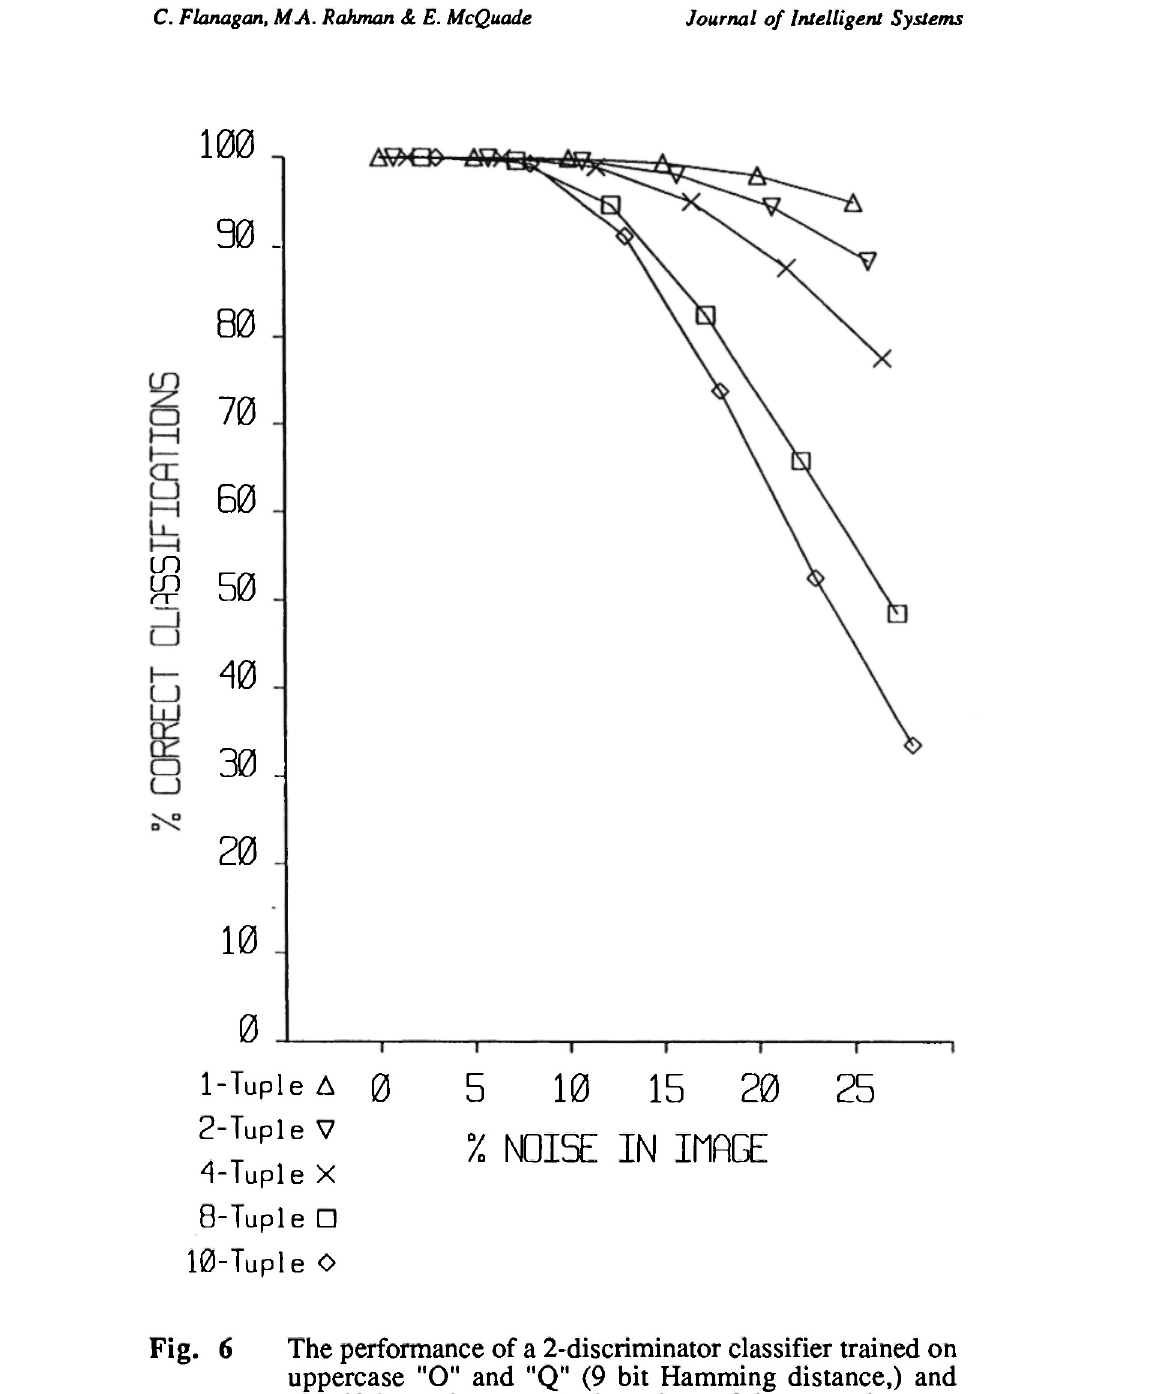
Fig. 6 The performance of a 2-discriminator classifier trained on uppercase "O" and "Q" (9 bit Hamming distance,) and classifying noise-corrupted versions of these two